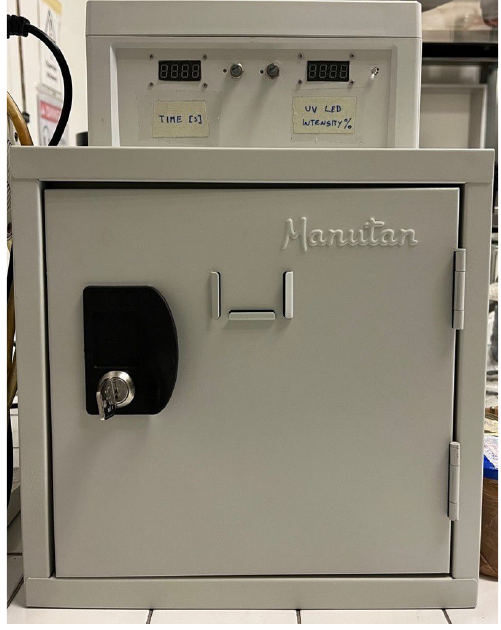
Figure 4. UV-curing prototype